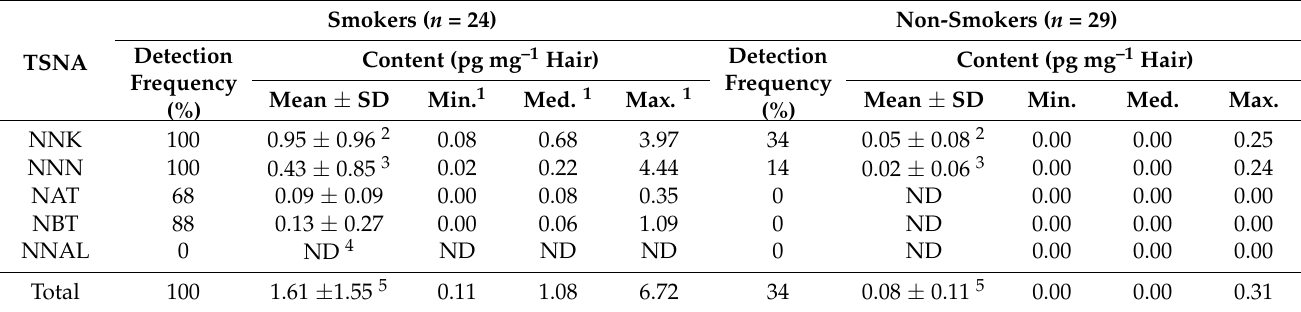
Table 4. Detection frequencies and contents of TSNAs in hair samples of smokers and